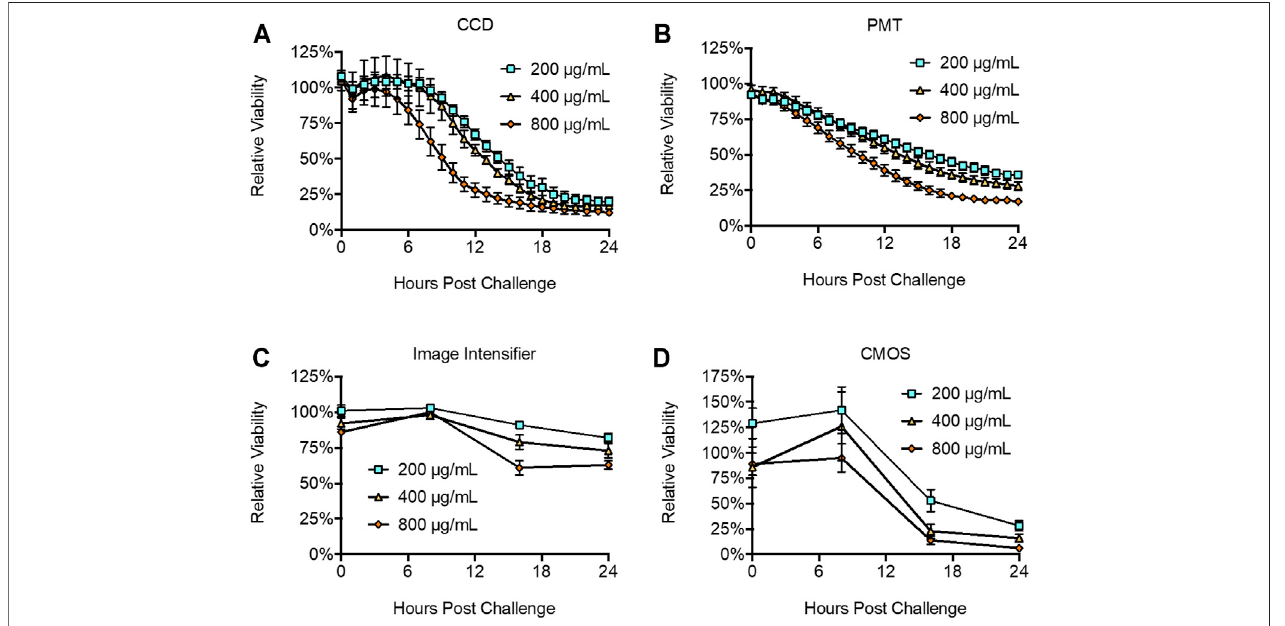
FIGURE5| DetectionoftoxicityfollowingZeocinchallenge.The (A) CDD, (B) ,PMT, (C) imageintensi fi er,and (D) CMOSsystemsallsuccessfullyreporteddeclines in cellular health following Zeocinchallenge. The (B) PMT system was themost sensitive, reporting signi fi cant differences at 1 h post challenge. The (A) CCD system did notdiscriminateastatisticallysigni fi cantchangeuntil8 hpostchallenge,whilethe (C) imageintensi fi erand (D) CMOSsystemsbothrequired16 htoidentifyastatistically signi fi cant change. Untreated control is de fi ned as 100% viability. n (cid:2) 3; error (cid:2) S.E.M.